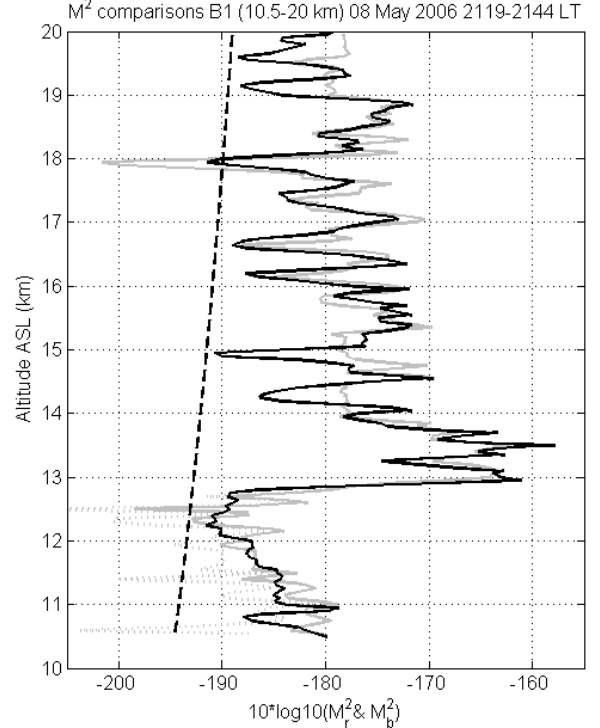
Fig. 4a. Comparisons for the flight B1 between profiles at a vertical resolution of 50m of M 2 r (black line) and M 2 profiles including humidity and grey dotted line without humidity). An approximate radar noise level is shown as a black dashed line.